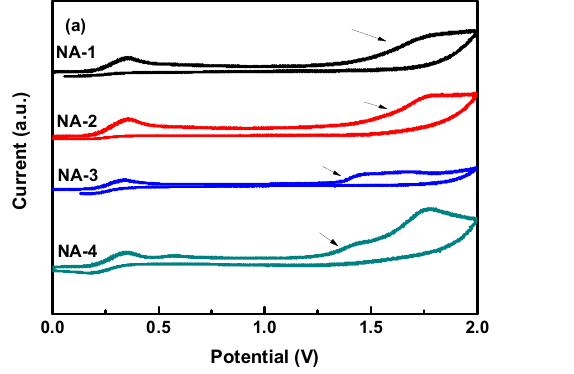
Figure 3. ( a ) Oxidation and ( b ) reduction potentials obtained from cyclic voltammograms of NA-1–4 in CH 2 Cl 2 solution (scan rate 100 mVs − 1 ).